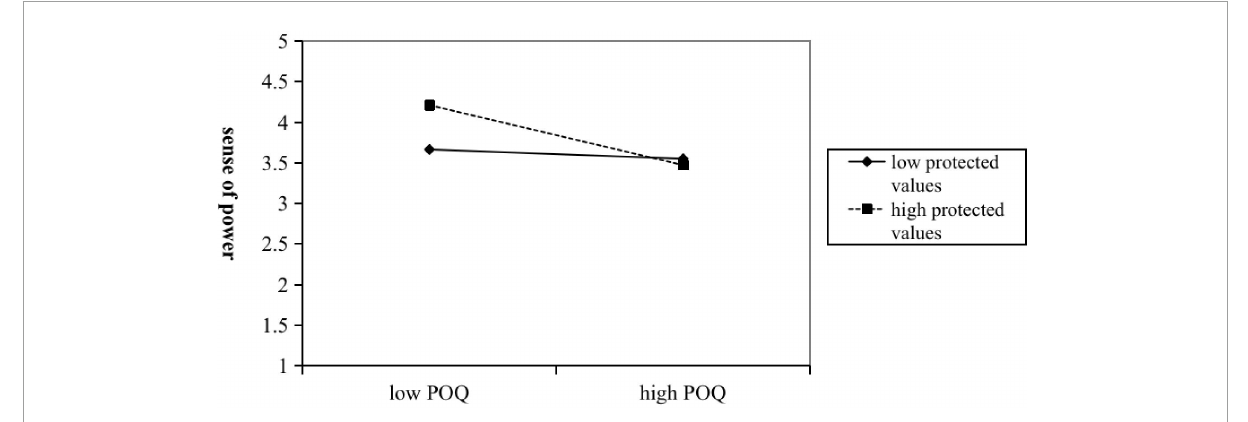
FIGURE2 Two-way interaction effect between POQ and protected values on sense of